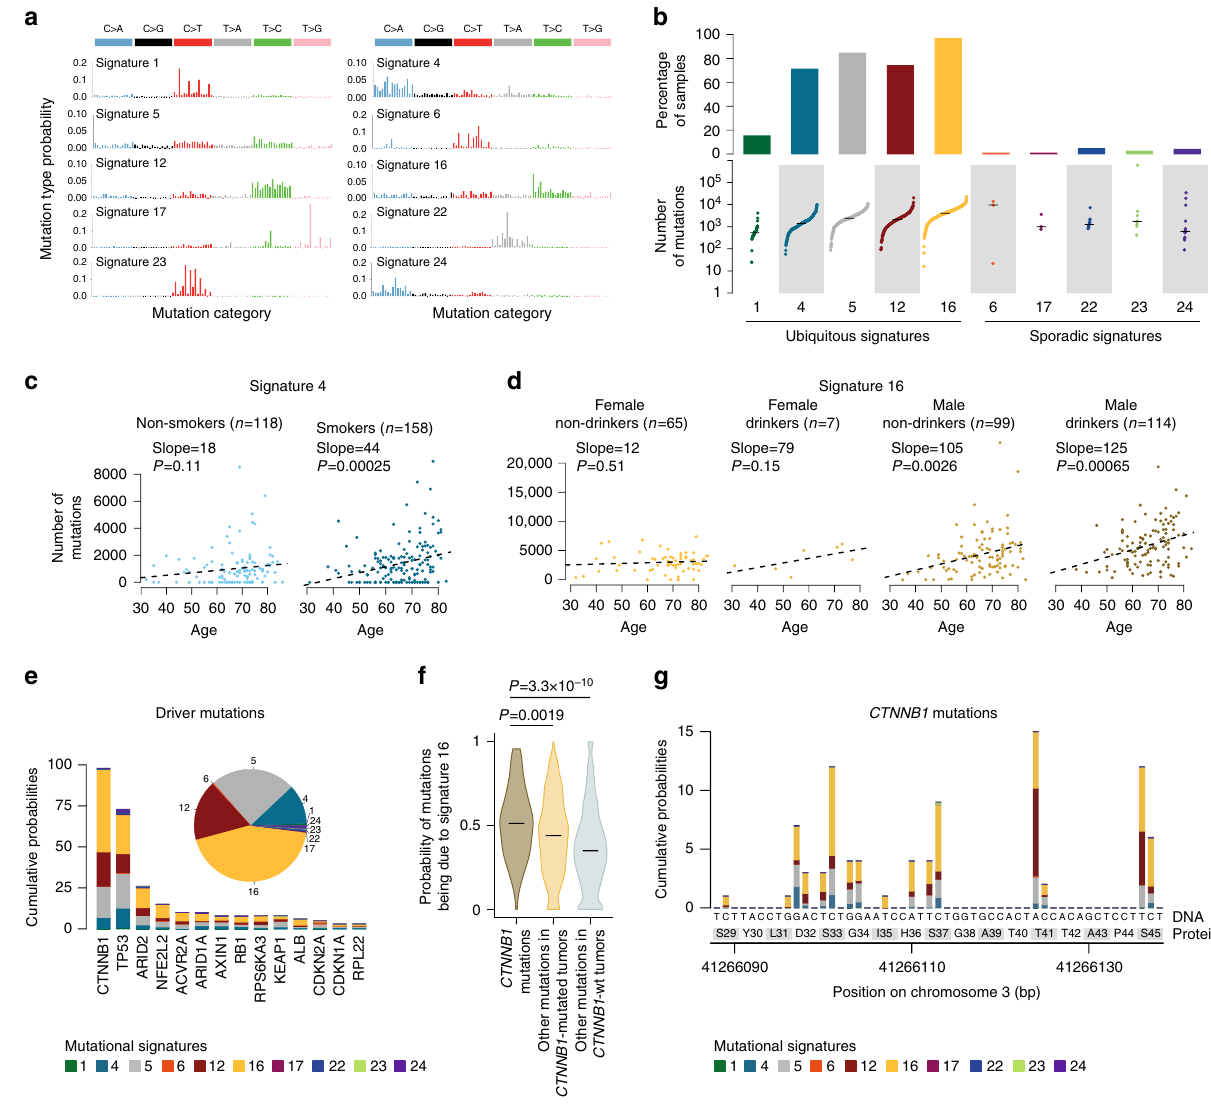
Fig. 1 Mutational processes are modulated by risk factors and preferentially alter speci fi c hotspots. a Summary of the 10 signatures (COSMIC nomenclature) known to be operative in liver cancers analyzed in our combined series of 299 HCC. Each signature is displayed according to the 96- substitution classi fi cation de fi ned by the substitution type and sequence context immediately 5 ′ and 3 ′ to the mutated base. b Proportion of samples in which each signature was detected (top) and distribution of mutation counts for each signature in the relevant samples (bottom). c , d Correlation of mutational signatures with risk factors and age. The number of mutations attributed to signatures 4 c and 16 d is represented as a function of age for patient groups strati fi ed according to the risk factors signi fi cantly associated with each signature (Supplementary Table 5). e Distribution of mutational signatures associated with driver gene mutations. We estimated the probability of each driver gene mutation being due to each mutational process. We then summed these probabilities over all mutations and signatures to obtain the cumulative probabilities across all driver gene mutations (pie chart) and for each driver gene separately (barplot). f CTNNB1 mutations (left) overall have higher probabilities being due to signature 16 than other mutations in the same samples (middle) and in other samples (right). The violin plots represent the distribution of probabilities for each group of mutations and horizontal segments highlight median values. g Distribution of mutational signatures associated with CTNNB1 mutations across the main oncogenic hotspots. The probability of each CTNNB1 mutation being due to each mutational process was estimated and summed across each position between amino acids S29 and S45, the main oncogenic hotspots of CTNNB1 . The DNA and protein sequence are depicted below the